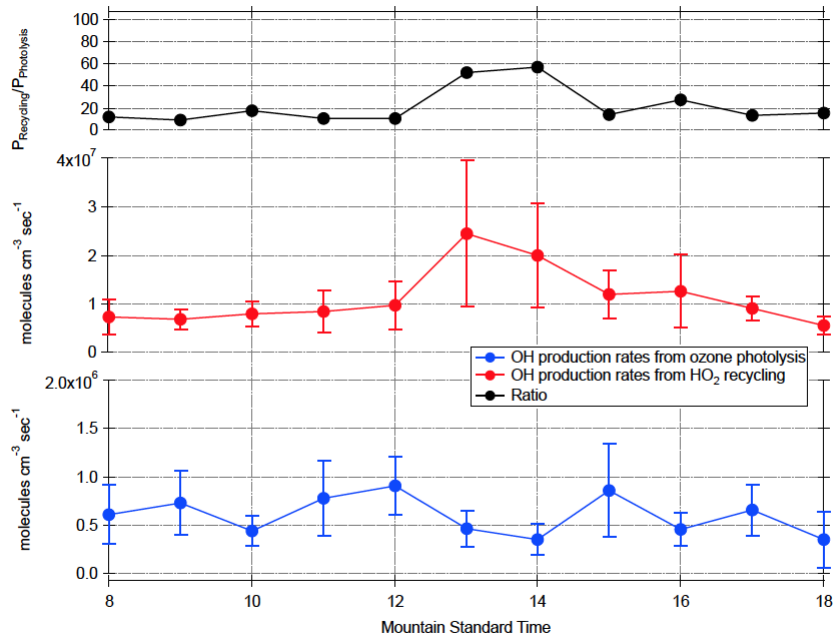
Fig. 5. Averaged diurnal cycles of OH photolysis production rates (blue), OH recycling rates (HO 2 + NO, red) and their ratios (black) during the BEACHON-ROCS field